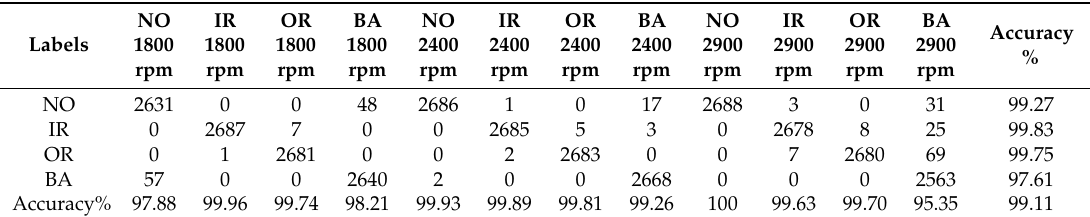
Table 7. Accuracy of test samples at different rotating speeds using PSPP-CNN.